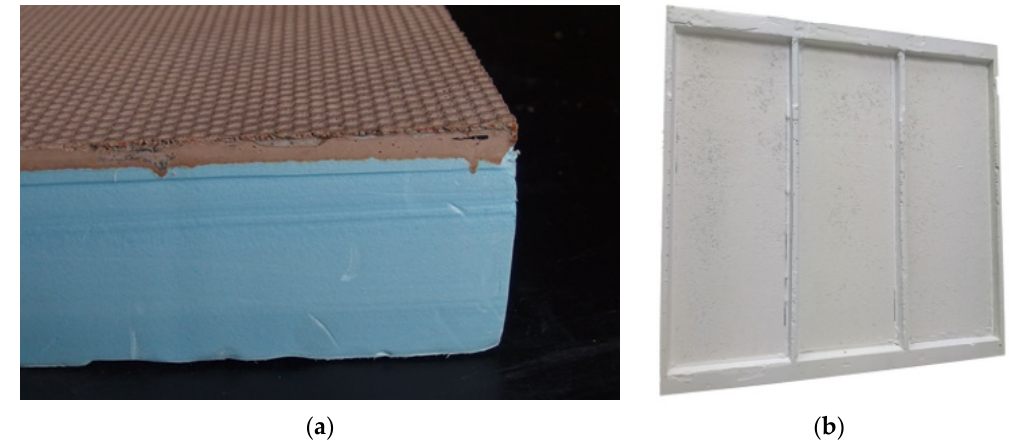
Figure 19. InnoWee geopolymer-based prototypes: ETICs panel ( a ) and ventilated façade cladding panel ( b ) (reproduced with permission from InnoWEEE Consortium).